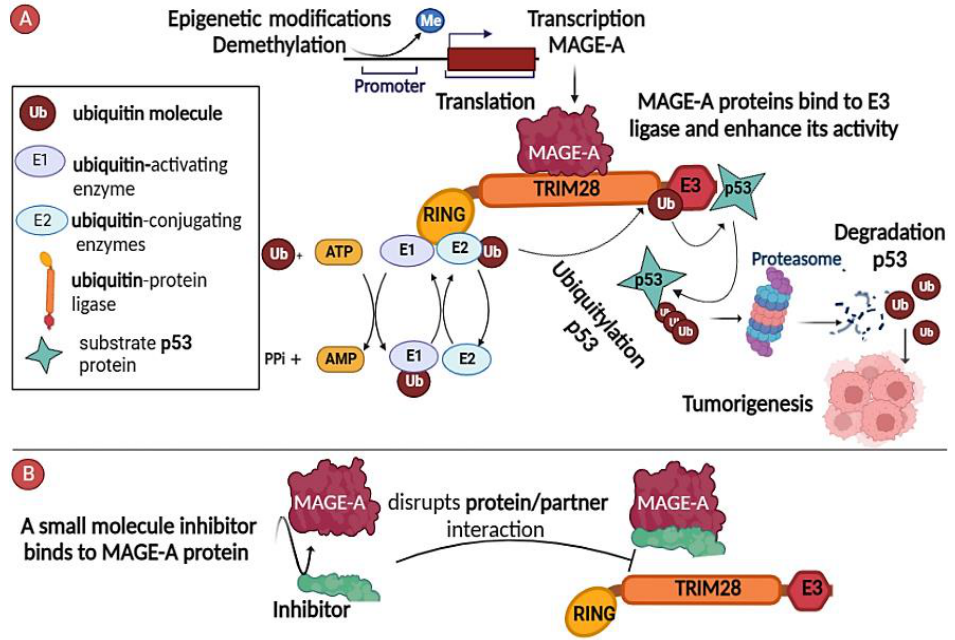
Figure 1. MAGE-A antigens as cancer therapeutic targets. ( A ) MAGE-A plays a role as the scaffold for the ubiquitin-protein ligase E3, which forms a complex with the TRIM28 protein. The MAGE-A genes are activated by epigenetic modifications, such as demethylation. MAGE-A binds to TRIM28, enhancing the ubiquitin ligase E3, which binds the tumor suppressor p53 and tags it for degradation by the proteasome, thus resulting in tumorigenesis. ( B ) Small molecule inhibitors of the MAGE-A interaction with partner protein TRIM28 are being developed to exploit MAGE-A proteins as cancer therapeutic targets.